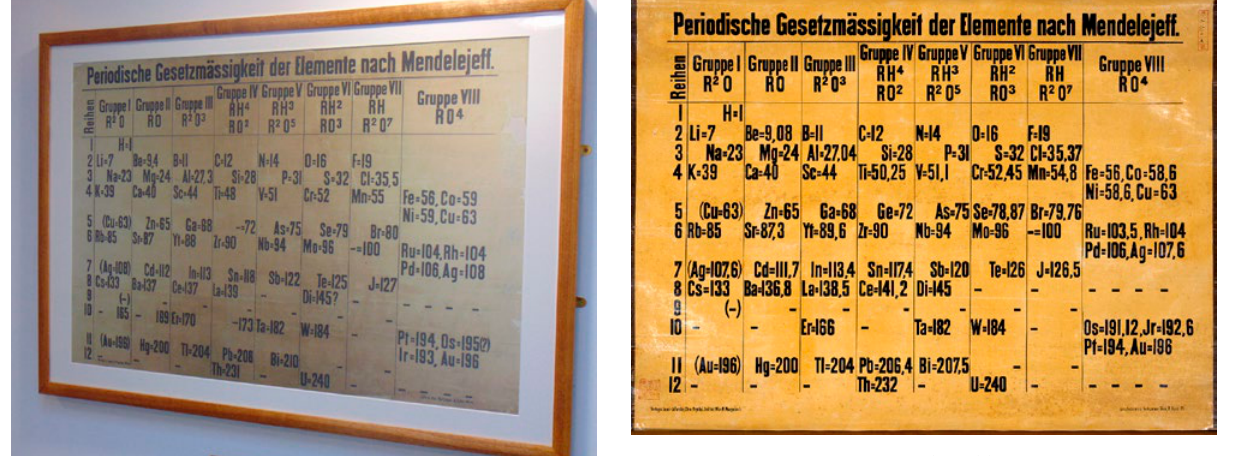
Figure 4. Kyoto University periodic table, 1893. Kyoto